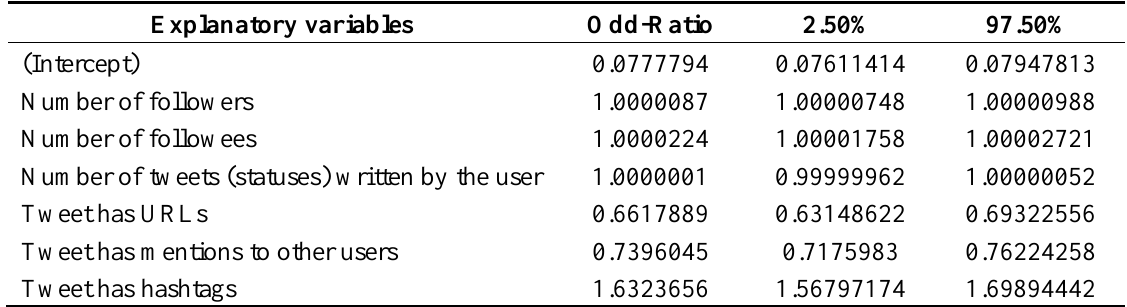
Table 3. Logit model for retweeted tweets. Odd-ratios and confidence intervals dependent variable: Retweeted tweet (1 = Yes, 0 =